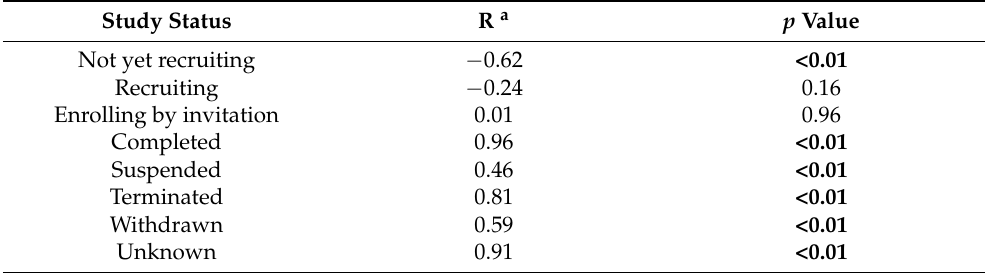
Table 5. Sensitivity analysis comparing ongoing trials to other types of